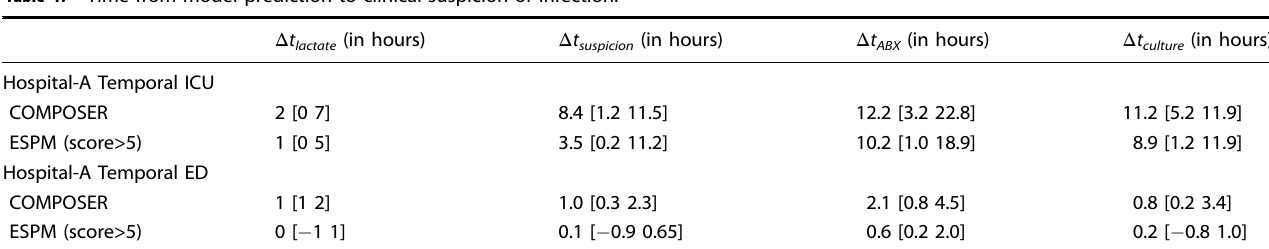
Table 1. Time from model prediction to clinical suspicion of infection.